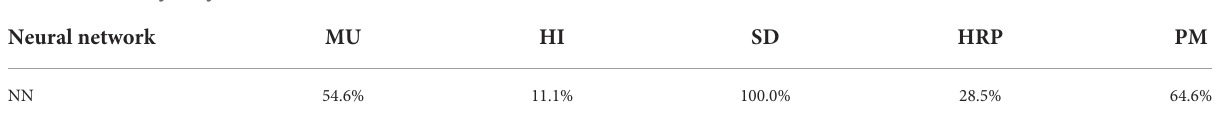
TABLE 8 Sensitivity analysis (ANN model for PA-COVID).